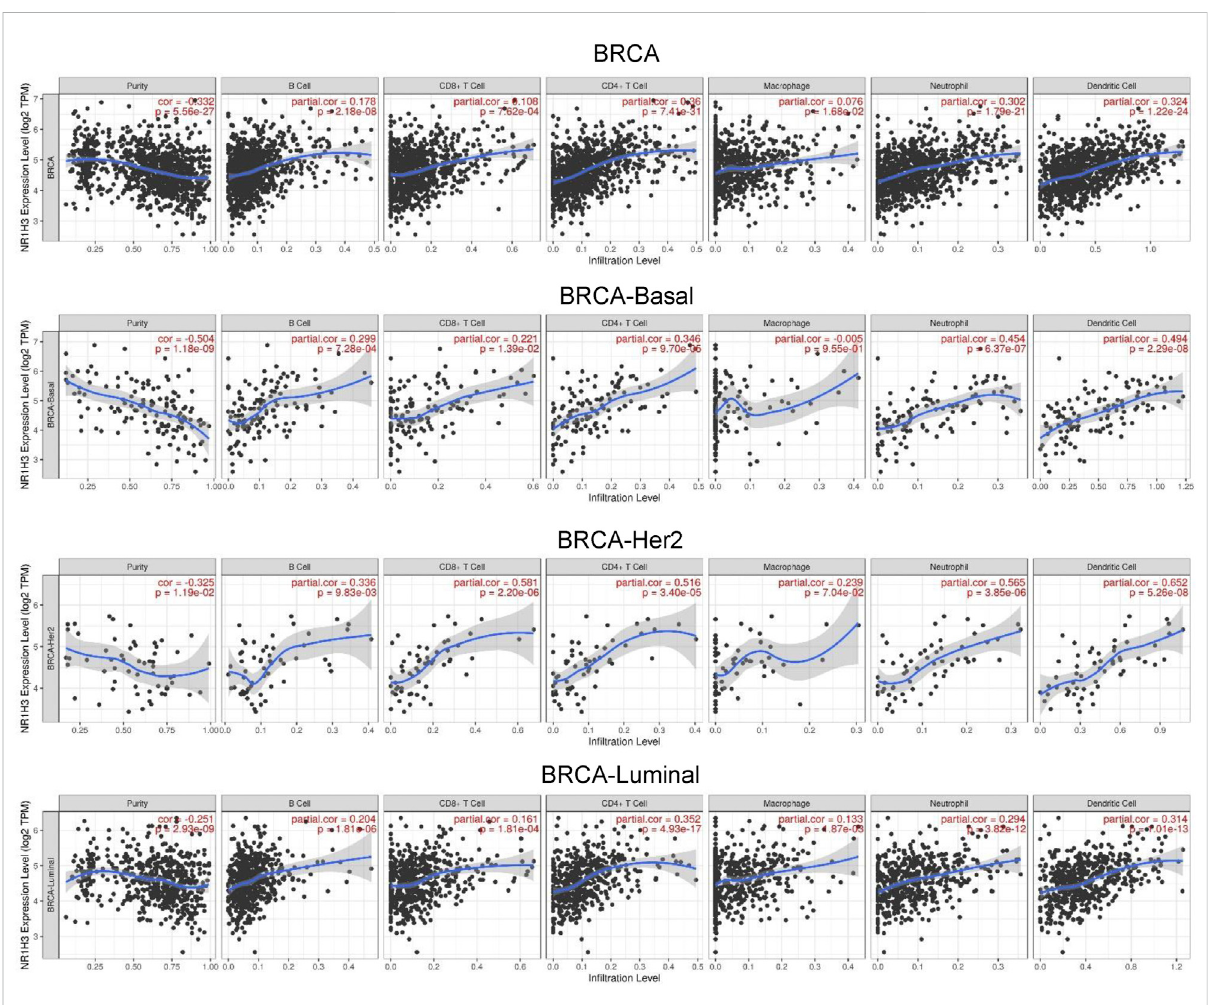
FIGURE 4 Correlation of NR1H3 expression with 6 types of in fi ltrating immune cells (B Cells, CD4 + T Cells, CD8 + T Cells, neutrophils, macrophages, and DCs) in BRCA and each subtype available in TIMER. DCs, dendritic cells; BRCA, breast invasive